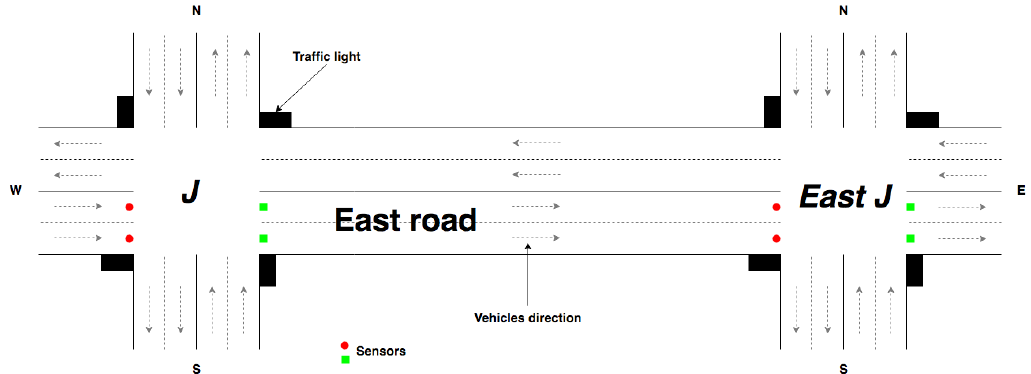
Figure 3. Illustration of sensors deployment on adjacent arterial junctions.